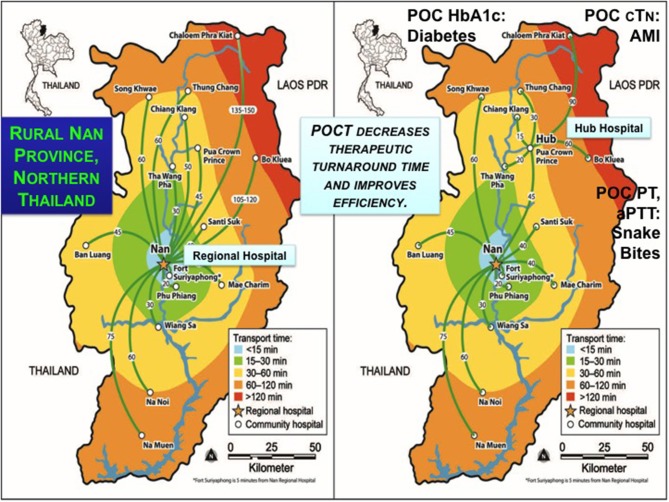
Contour maps and hub concept for efficient regional care in Nan Province, Northern Thailand. The left frame shows the SWN of rural Nan Province, and the right, the utility of a hub hospital to improve efficiency by decreasing transit times indicated by temporal contours. Pont-of-care testing can accelerate evidence-based decision making for the conditions shown, which community hospitals identified as high priority. Image reproduced with permission of Knowledge Optimization.